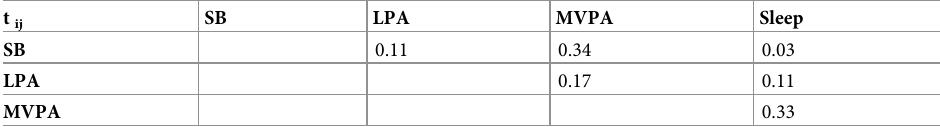
Table 3. Pair-wise log-ratio matrix of the four-part time-use